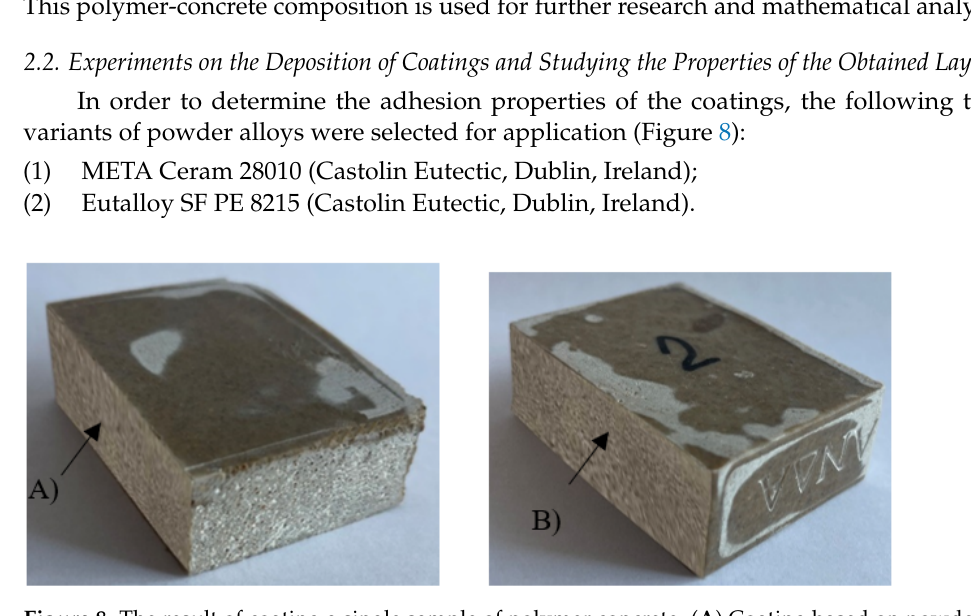
Figure 9. Microstructure of the Cr 2 O 3 coating. A—pull. Table 9. Physical and mechanical parameters of the Cr 2 O 3 coating. HV 0 . 5 (according to the dint diagonal)